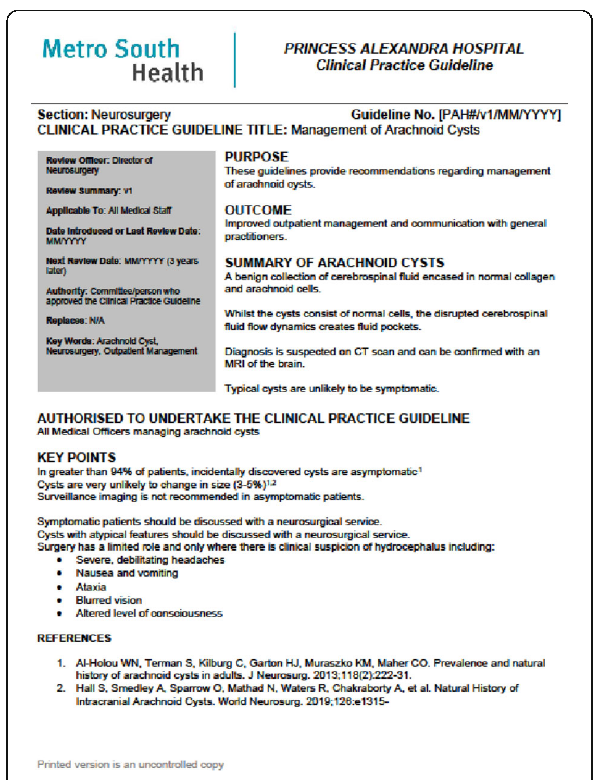
Fig. 2 (abstract P36). See text for